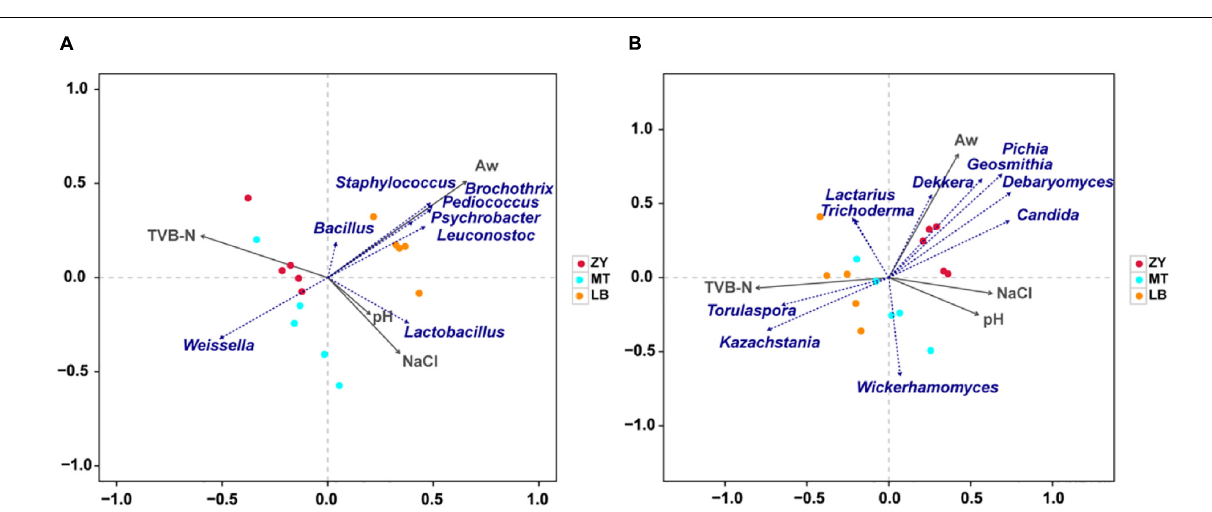
Lactobacillus , were unexpectedly eliminated from the microbial correlation